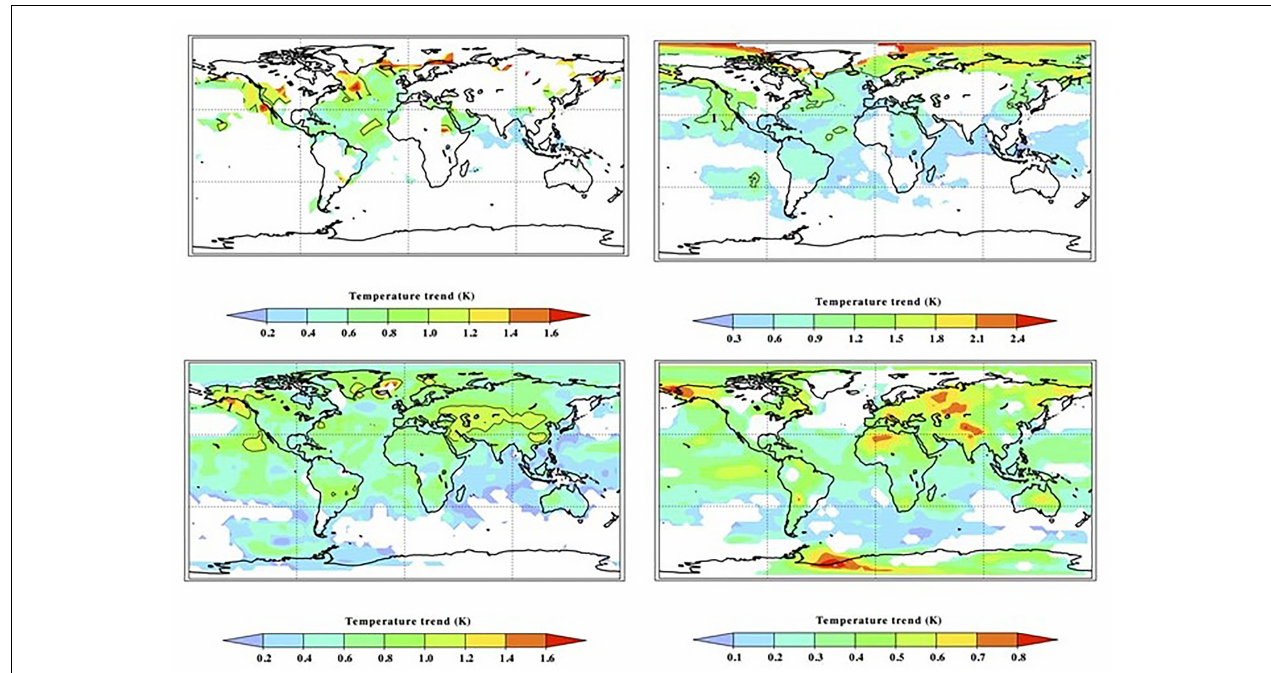
FIGURE 2 | Geographical distribution of annual mean temperature change (K) during the 1910–1940 period calculated from linear trend HadCRUT4 (upper left), BEST (upper right), CCC400 (lower left), and our model results (lower right). The areas where the trend is significant on 95% or a better level are shown in color. Please note the difference in color scale ranges, which illustrates generally smaller warming magnitude in our model results.